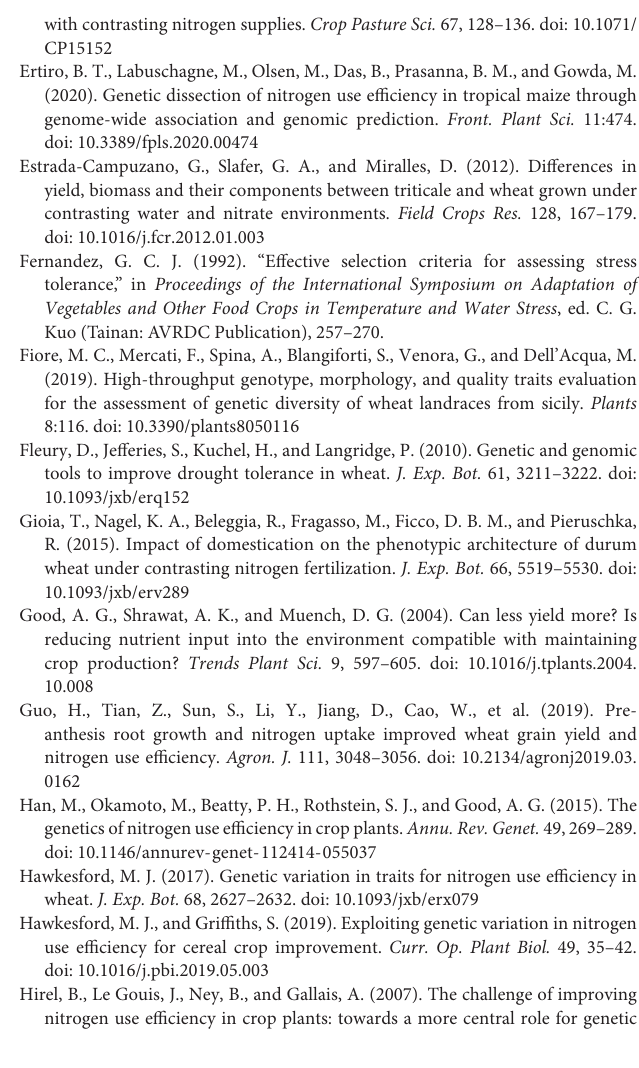
Supplementary Figure 2 | Phenotypic variance partitioning of morpho-physiological durum wheat traits under different N and water availability. DWTI, dry weight tillering; DWSE, dry weight stem extension; DWAN, dry weight